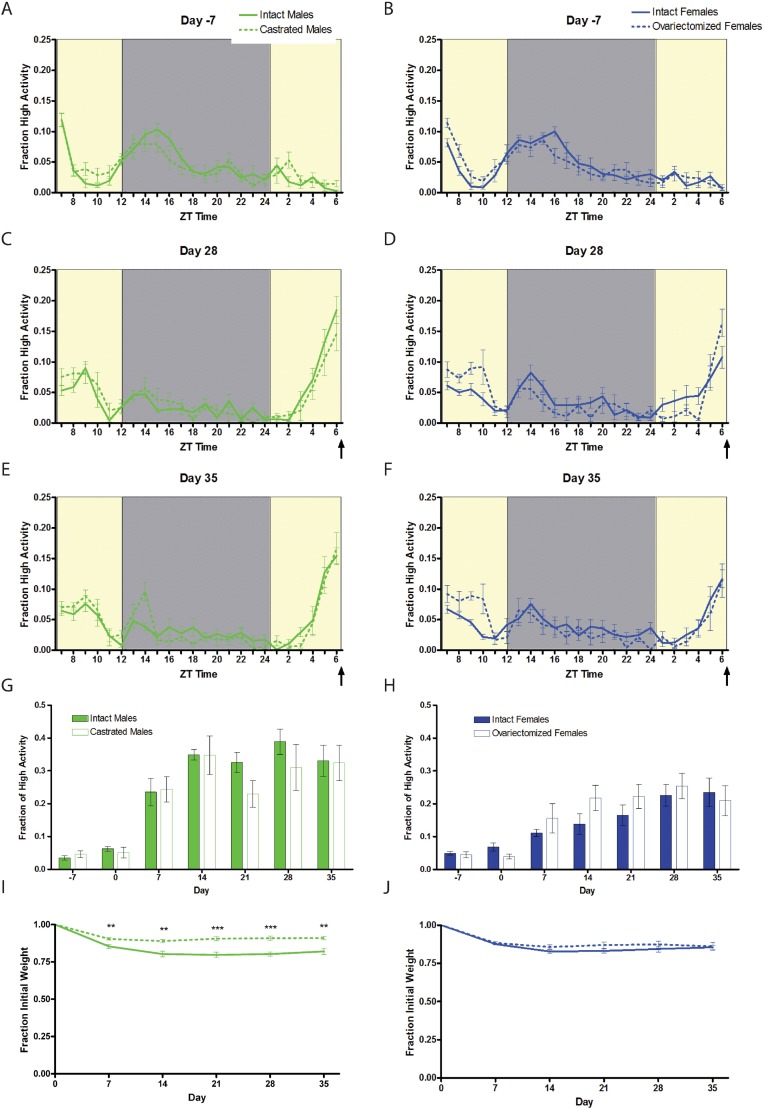
Lack of effect of gonadectomy on food anticipatory activity.Mean (+/- SEM) normalized high activity behaviors seven days prior to initiating scheduled CR feeding in (A) male (solid green) and castrated male (dashed green) and (B) female (solid blue) and ovariectomized (dashed blue) mice. Normalized mean high activity of (C) male and castrated males on day 28, (D) female and ovariectomized females on day 28, (E) male and castrated males on day 35, and (F) female and ovariectomized females on day on day 35. Mean normalized high activity data in the three hours preceding scheduled feeding across 35 days of the experiment for (G) intact versus castrated males and H) intact versus ovariectomized females. (I) Mean body weights loss for intact and castrated males. (J) Mean body weight loss for intact and ovariectomized female mice on a CR diet for five weeks. ** P<0.01; *** P<0.001, Student T test. n = 7–8 per group. The arrow indicated the time of expected food delivery (ZT7).